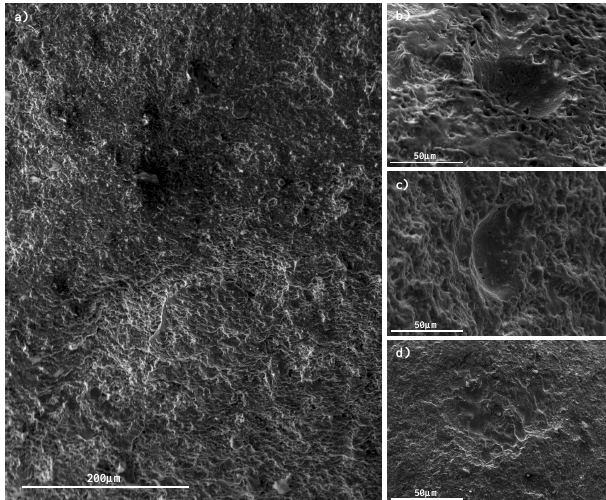
Fig. 7 [Jones et al., Solid Earth, 2014] Figure 7. SEM imagery for Igwisi Hills lava olivine. (a) Large- scale image showing distinctive surface texture. (b) Hemispheri- cal impact cavity featuring a smooth interior. (c) A common semi- hemispherical impact pit, again having a smooth interior. (d) Sev- eral semi-hemispherical excavations; the edge of this attrition fea- ture demonstrates penetrative multiple layer flaking of the olivine